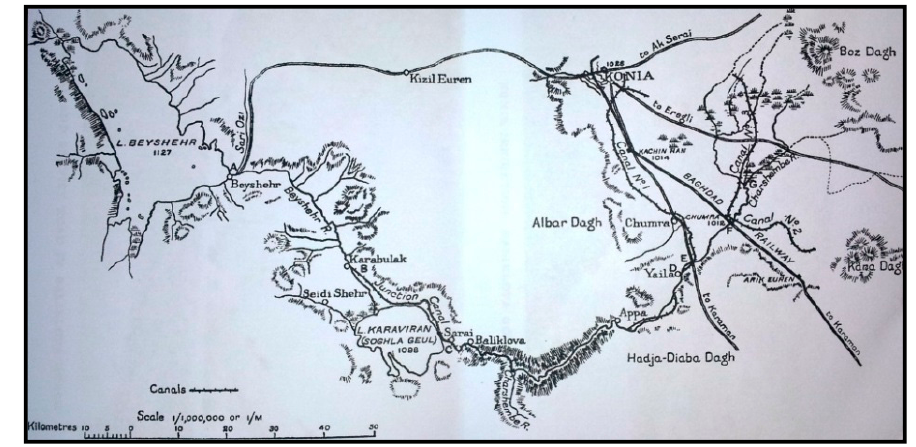
Figure 18. Sketch map illustrating the irrigation network of the Konia Plain (adapted from [137])